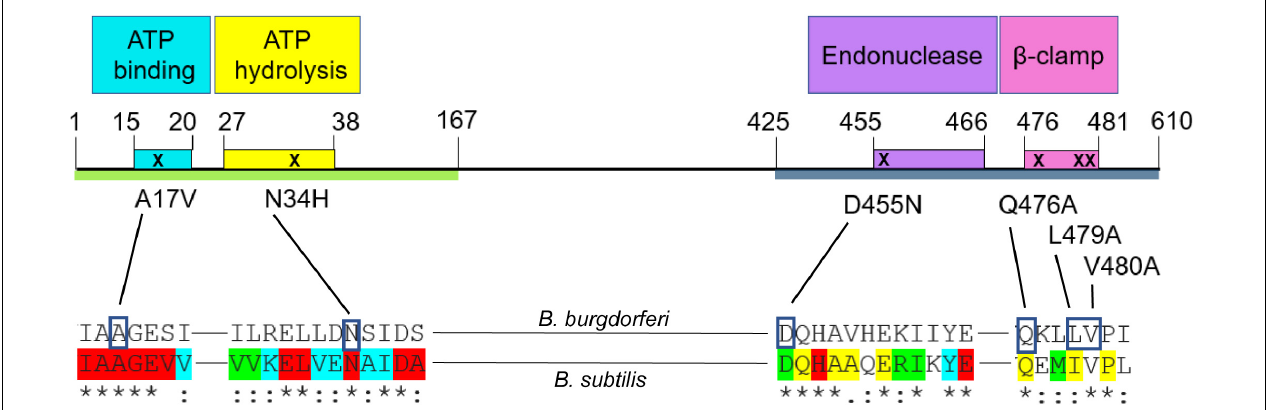
FIGURE 6 | Schematic of Borrelia burgdorferi MutL protein and point mutations introduced in this study. The green line represents the N-terminal (ATPase) domain of MutL (Bolz et al., 2012) and the blue one, the C-terminal domain (endonuclease) domain (Pillon et al., 2010, 2011). The colored boxes represent the conserved motifs that confer different activities to the protein (Pillon et al., 2010, 2011; Bolz et al., 2012). Conserved residues in a lineup of about 200 MutL orthologs (Banasik and Sachadyn, 2014) are indicated at the bottom of the figure. The colors show different degrees of conservation, where red indicates an identical status in all the sequences included in the analysis. The blue color indicates only conservative amino acid changes in 100% of the proteins; green indicates only conservative amino acid changes in more than 90% of the sequences analyzed and yellow shows those residues with only conservative changes in 60–90% of the sequences analyzed. The asterisks indicate identical residues between the B. burgdorferi and B. subtilis alignment, the colons denote amino acids with conserved but non-identical